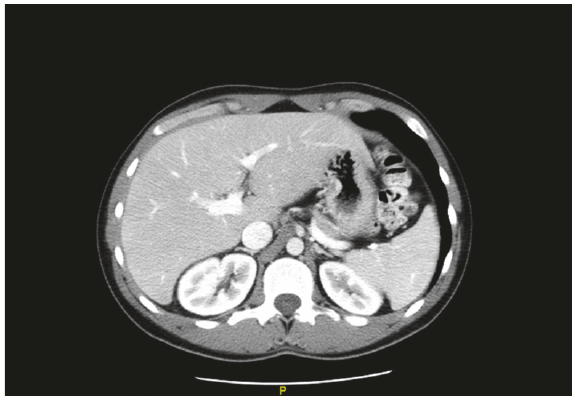
Figure 2: An axial CT imaging of the abdomen showing resolution of pyogenic liver abscess in this